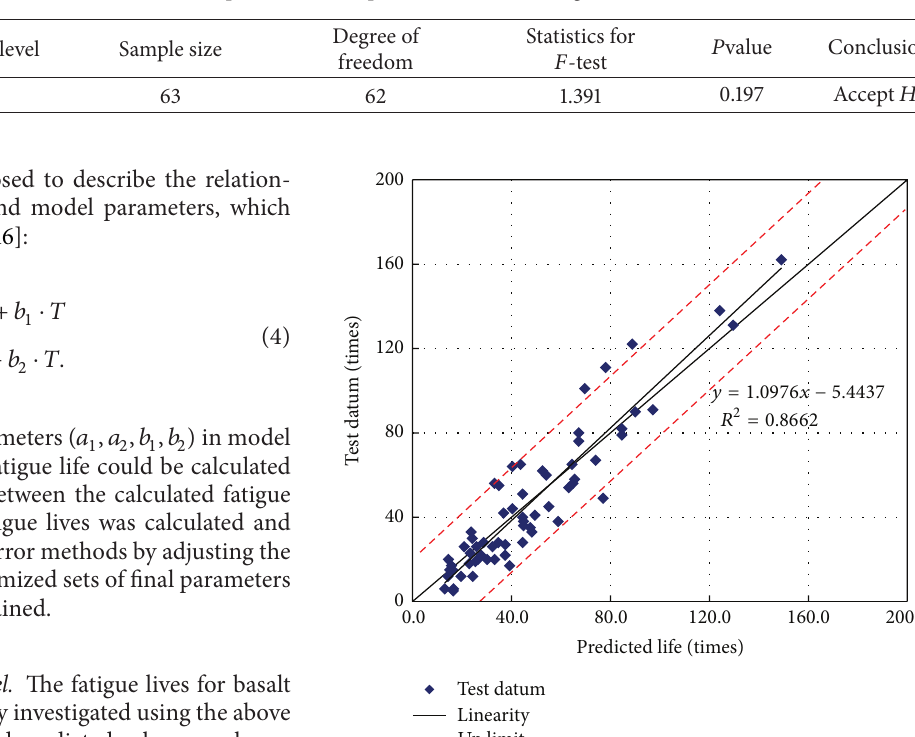
Table 3: Variance test for experimental and predicted adhesion fatigue lives.